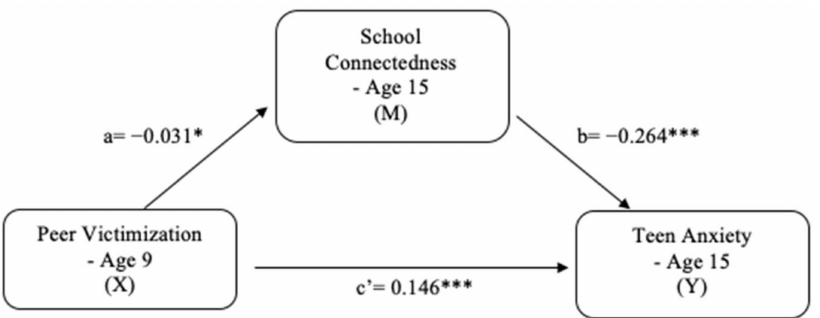
Figure 3. Mediation model for teen anxiety. * p < 0.05; *** p < 0.001. Note: The path coefficients (a, b, c’) estimate the strength of the hypothesized associations using unstandardized regression coefficients; a = the direct effect of X on M; b = the direct effect of M on Y; c’ = the direct effect of X on